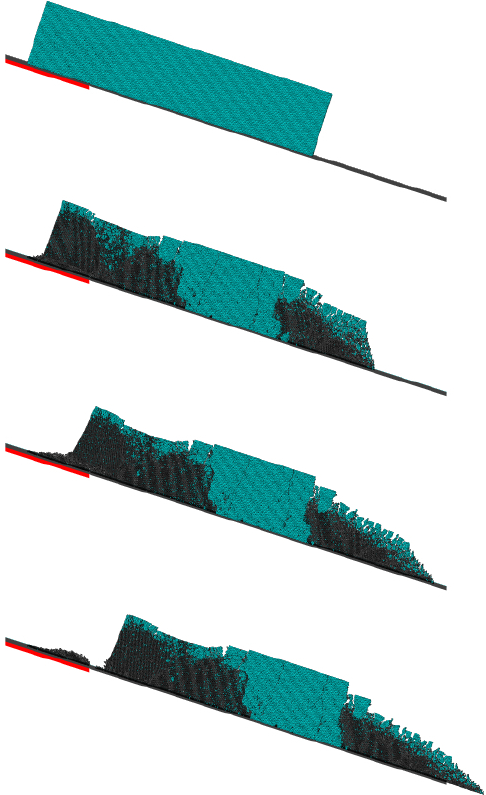
Fig. 6. Snapshots of a 200m × 50m ice-block on a 18 ◦ slope. The red line marks a high friction contact. The colours of the ice-block represent elastic areas where the elastic beams between particles have not been broken (green) and areas where beams are no longer intact (gray). The pressure of an upstream ice slab on the slope above the ice-block is not shown in the figure.